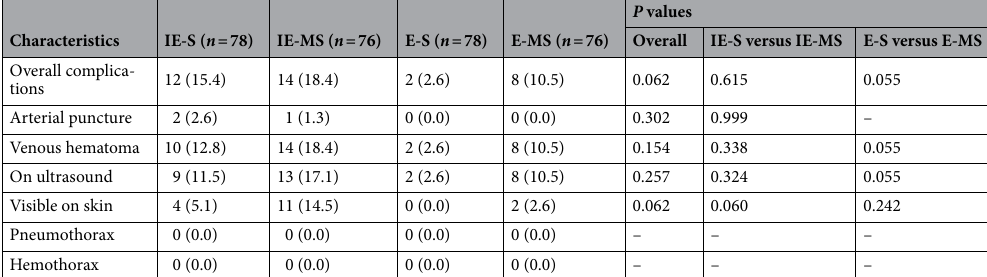
Table 3. Comparison of the catheterization-related complications between the four groups according to the practitioner’s experience and catheterization techniques. Values are presented as number (proportion). IE-S = inexperienced Seldinger technique, IE-MS = inexperienced modified Seldinger technique, E-S = experienced Seldinger technique, E-MS = experienced modified Seldinger technique. P values are the results of the chi-square test or Fisher’s exact test according to their expected